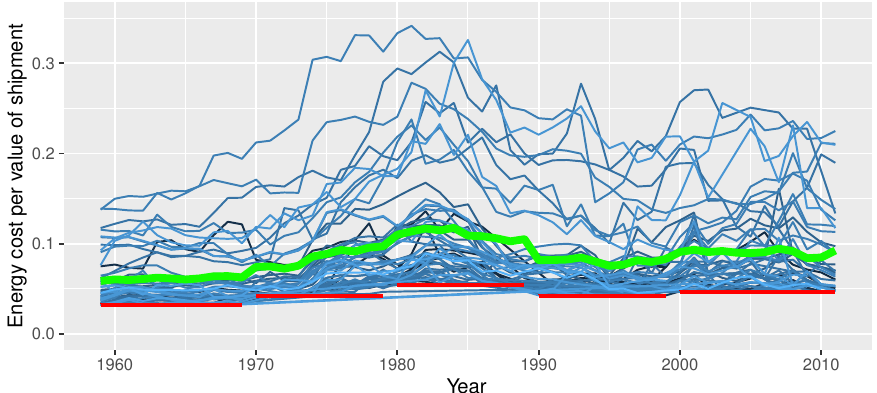
Figure 2. Energy intensity of industries. Shown are industries whose energy intensity exceeds the 90th percentile in a respective decade. Notes: Horizontal red lines show the 90th percentile of energy intensity in a respective decade. The bold green solid line shows the mean of energy intensity for industries whose energy intensity exceeds the 90th percentile in a respective